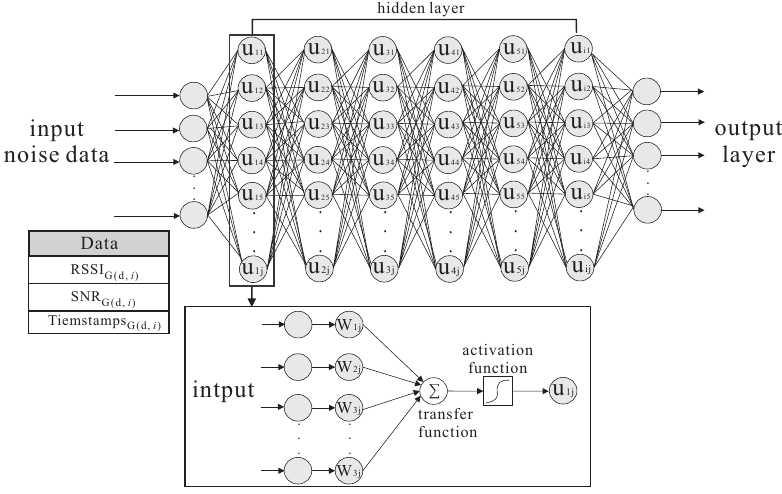
Figure 3. The Deep Neural Network system